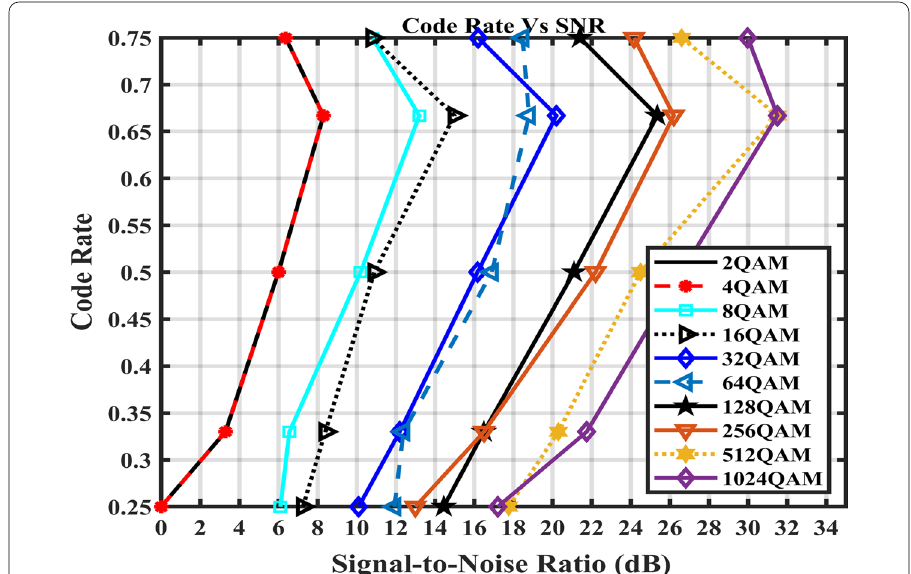
Fig. 16 Code rate versus SNR for different modulation schemes for target bit error rate of 10 − 5 . In this graph the effect of channel coding at a desired BER of 10 − 5 is presented by showing the performance of different M-ary QAM scheme with respect to code rate of 1/4, 1/3, 1/2, 2/3, and 3/4 over a range of SNR